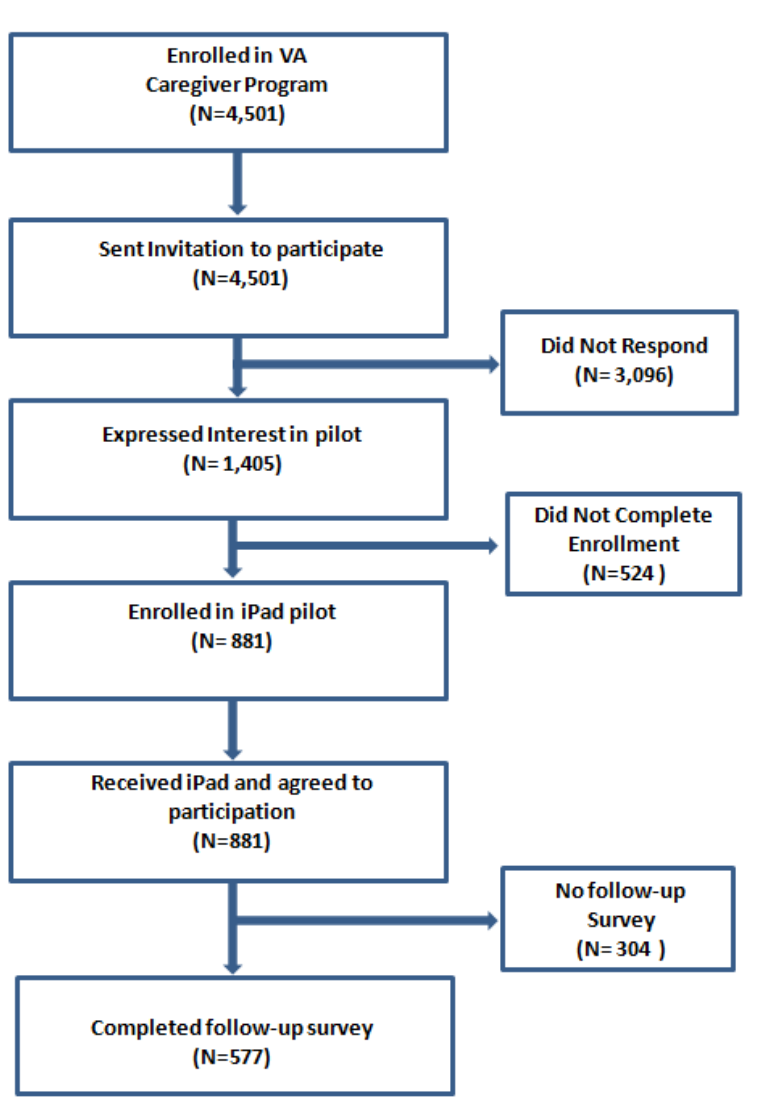
Figure 1. Consort diagram: how the study cohort was